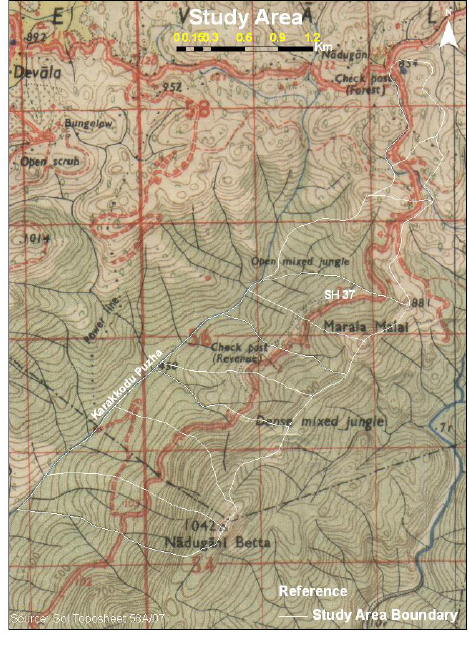
Figure 1 Study area map